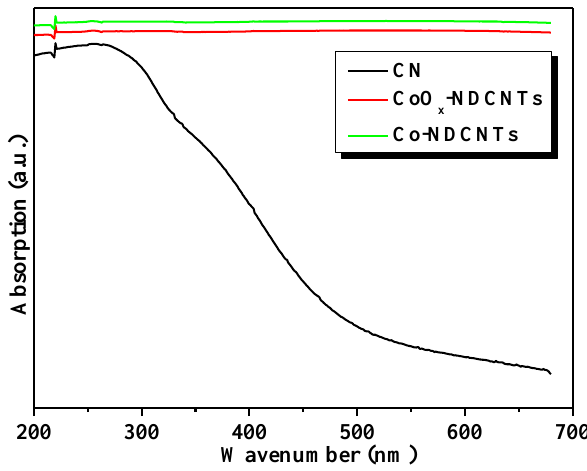
Figure 4. UV–Vis of pure g-C 3 N 4 , CoO x –NDCNTs and Co–NDCNTs. The flat band potential (EFB) is an important parameter for the semiconductor / solution system. Its numerical value can be used to describe the energy level structure of semiconductor electrode. Figure 5 shows that in the experimental voltage range, the slope of the M-S curve is negative, indicating that semiconductors exhibit p-type semiconductor characteristics [53].